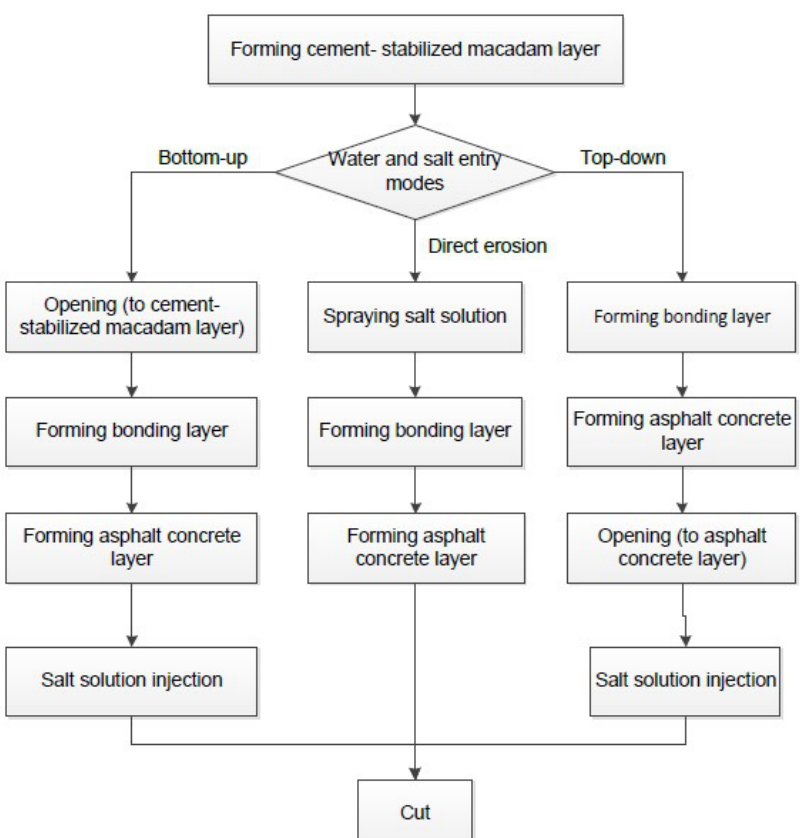
Figure 1. Flow chart of specimen forming.